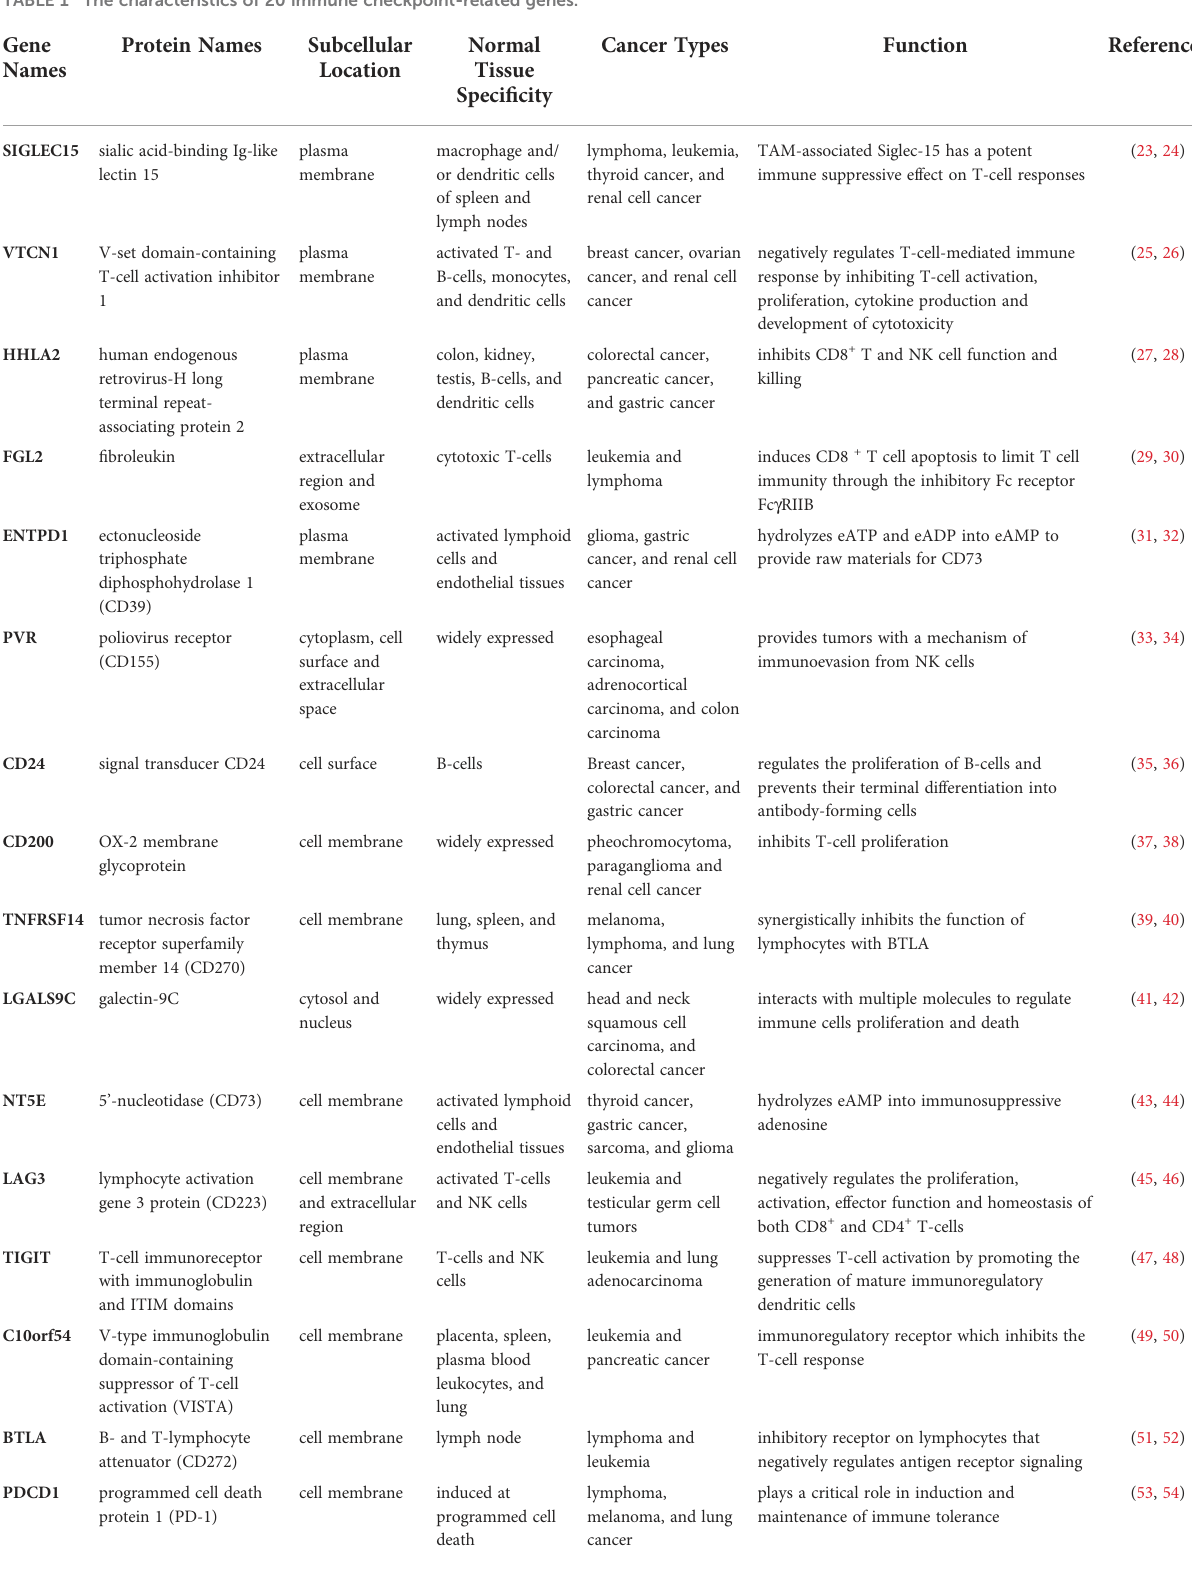
TABLE 1 The characteristics of 20 immune checkpoint-related